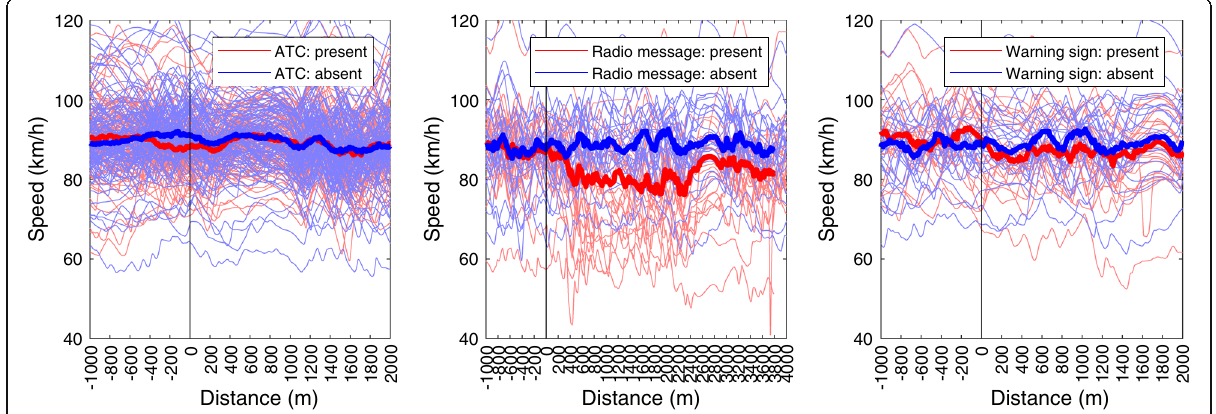
Fig. 4 Speed profiles calculated every 5 m from 1000 m before an event until 2000 m after the event, for all possible road segments according to Fig. 2. Aggregated mean values across all segments are illustrated with thick lines. The extent of the data surrounding the radio message has been extended to 4000 m. Note however that the last 2000 m are confounded by the potential presence of the moose